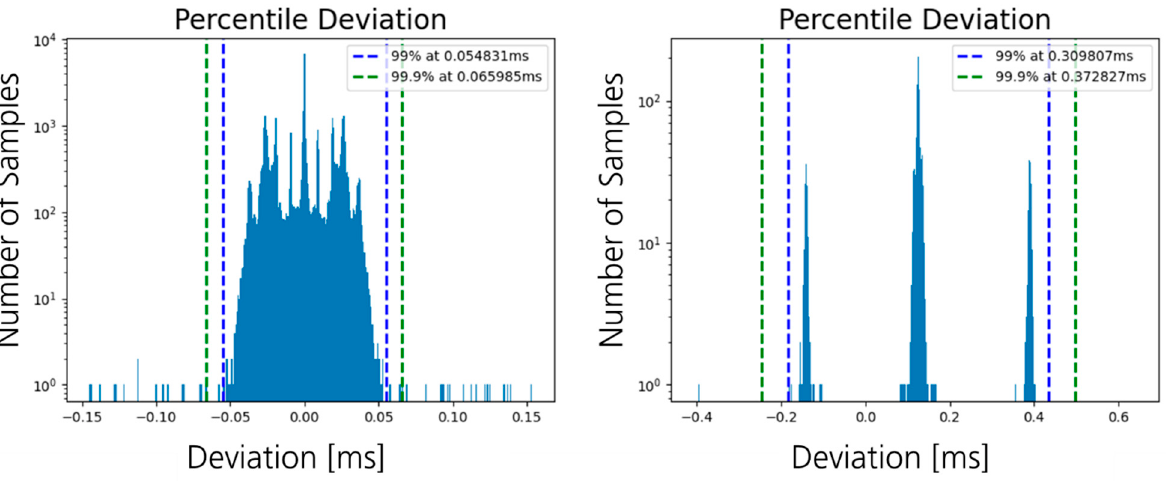
Figure 13. Left: Jitter of the PC output at the network card of the PC. Right: Jitter including over-the- air transmission at the egress gate of TSN-Switch 2 without scheduled traffic.